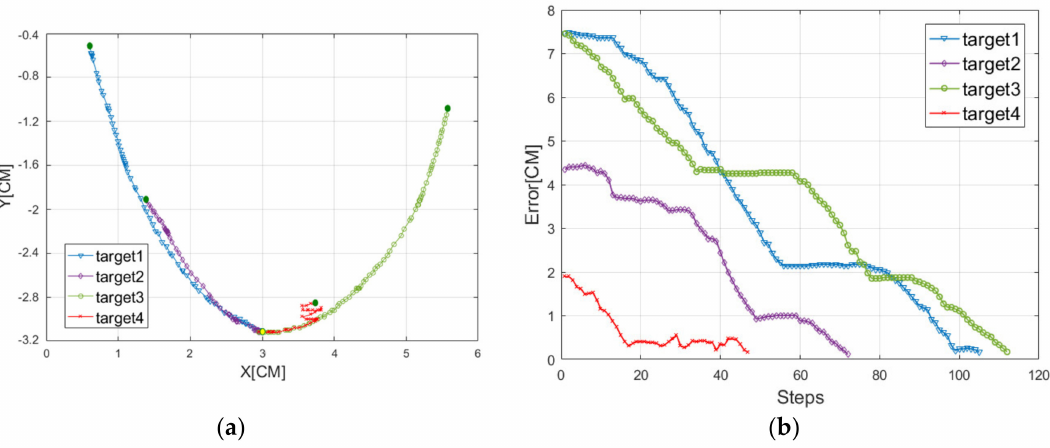
Figure 6. The End of Soft arm: Motion Trajectory and